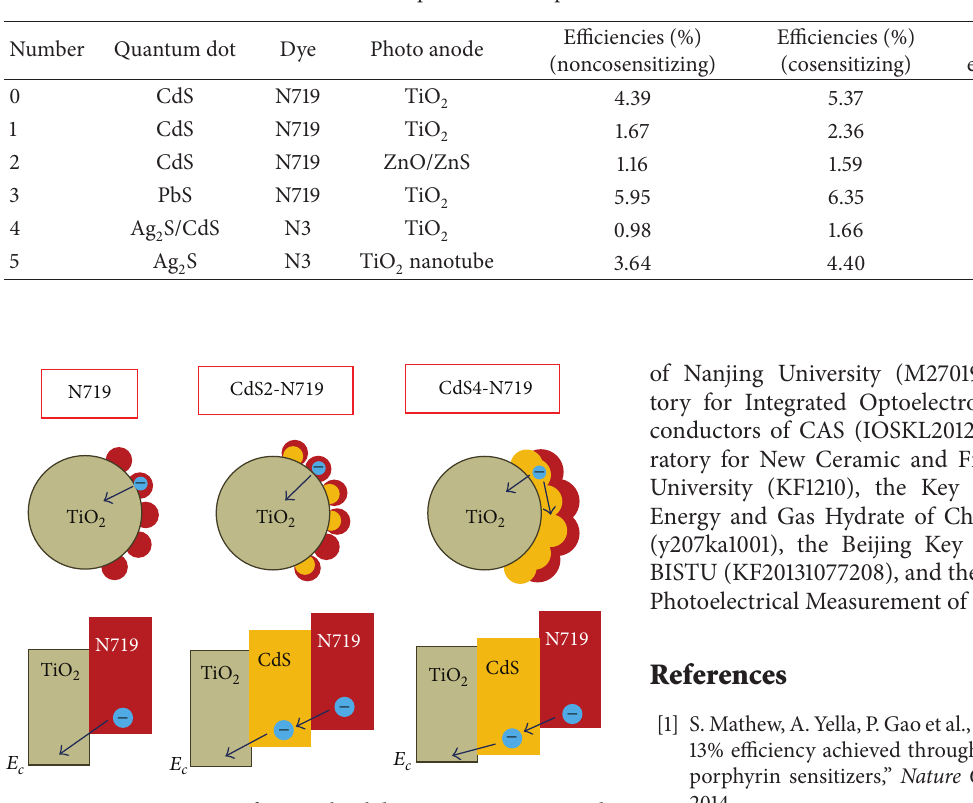
Figure 6: Representation of energy level diagram in a cosensitized DSSC by N719 and